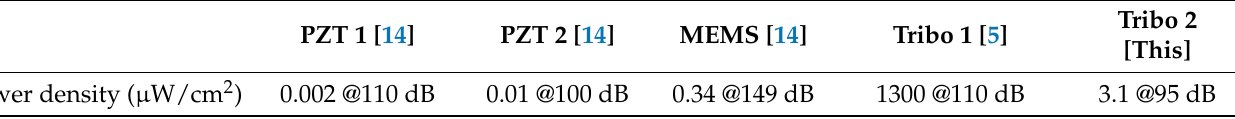
Table 2. A Helmholtz resonator with a piezoelectric backplate mechanism (PZT 1), a Sol/Gel enhanced piezoelectric element (PZT 2), microelectromechanical systems (MEMSs), an electrochromic nanogenerator based on Cu foam (Tribo 1), and our harvester (Tribo